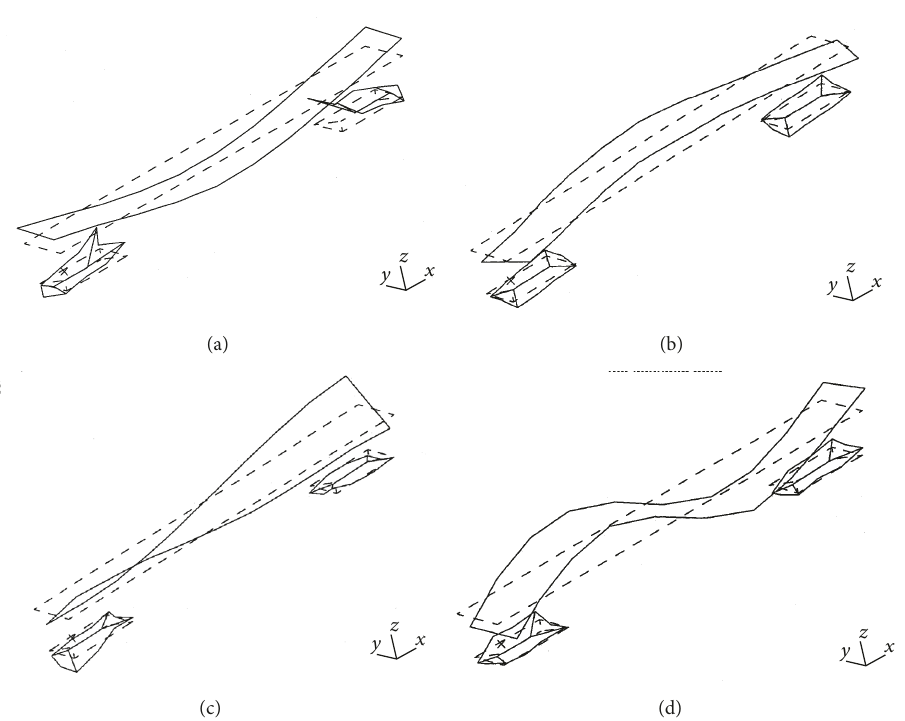
Figure 4: Natural modes of the car body, (a) first vertical bending at 9Hz, (b) first lateral bending at 11Hz, (c) first torsion at 14Hz, and (d) second vertical bending at 18Hz.